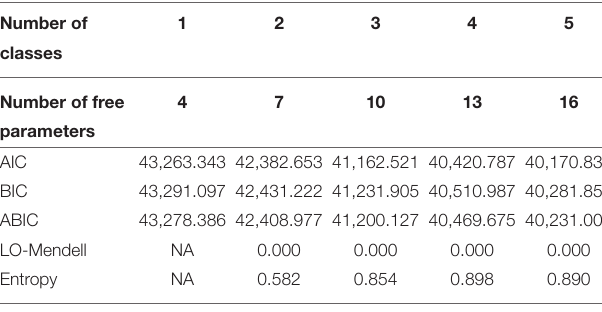
TABLE 3 | Fit indices for LPA social integration.